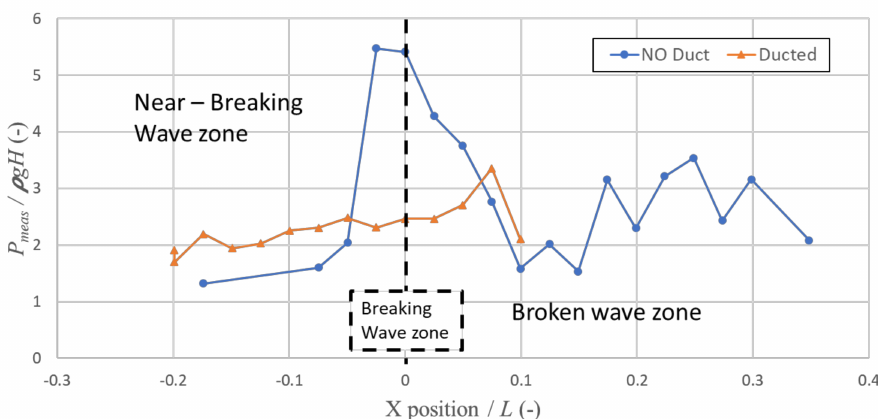
Figure 8. Landward pressure measurement graph of the no duct case (blue circle) and the ducted case (orange triangle). Pressure is normalized with hydrostatic pressure; the x-axis shows the location of the measurements normalized with the shallow water wavelength, with zero indicating the breaking wave